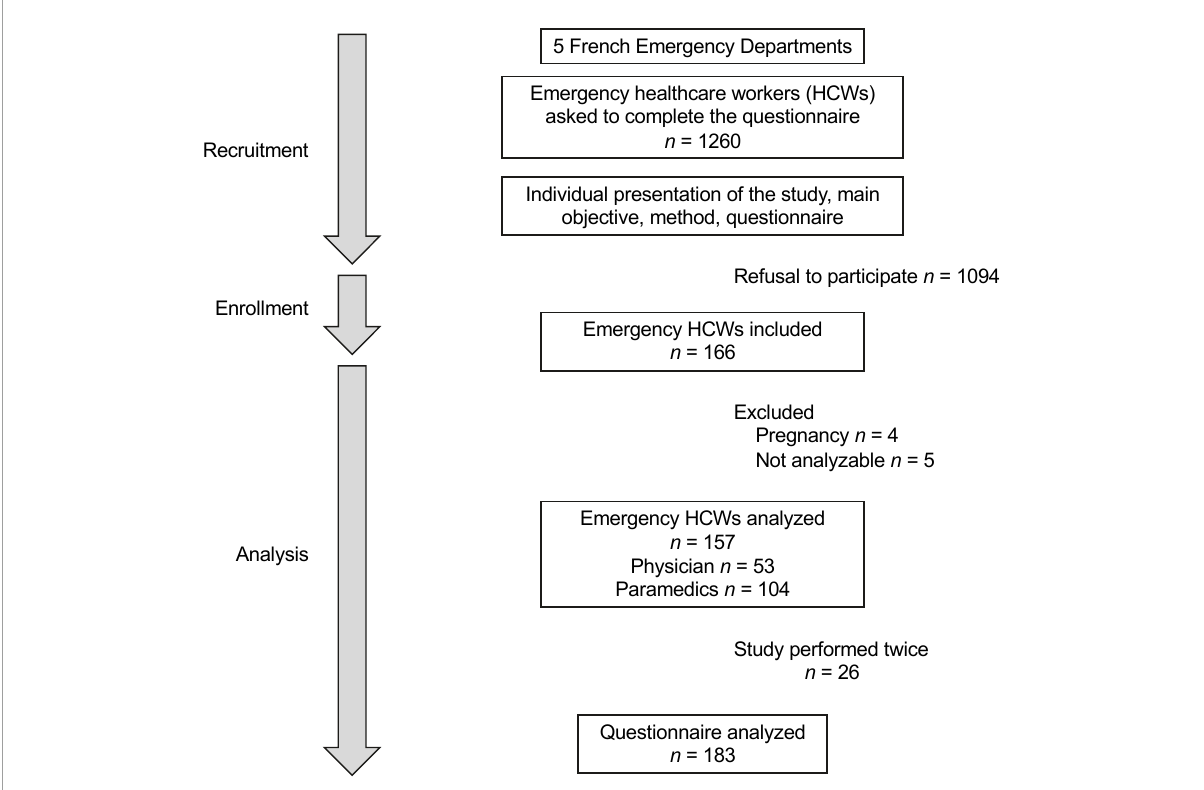
FIGURE1 Study design. Among the five French EDs, we were able to recruit 192 emergency healthcare workers (eHCWs). Nine were excluded because of pregnancy or no data completion. A total of 183 Karasek surveys were analyzed from 157